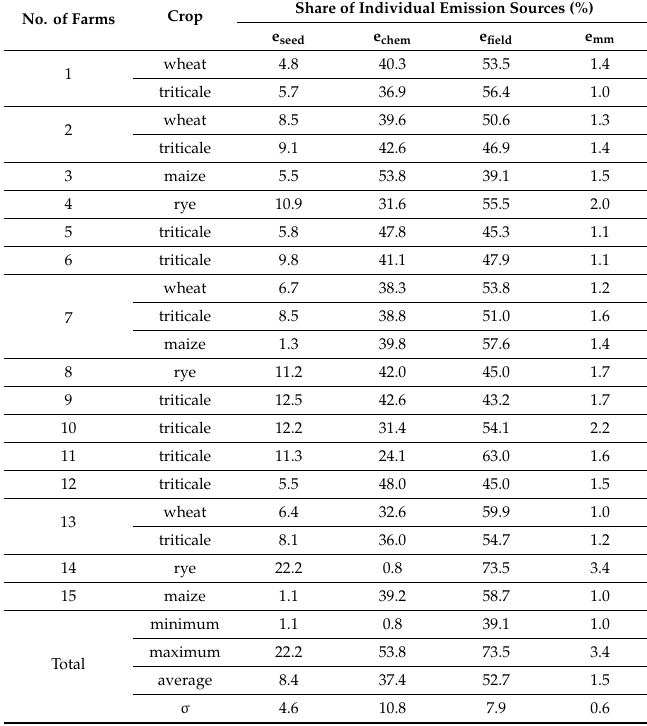
Table 4. The structure of GHG emissions from cultivation of agricultural crops for biofuels. Share of Individual Emission Sources No. of Farms Crop